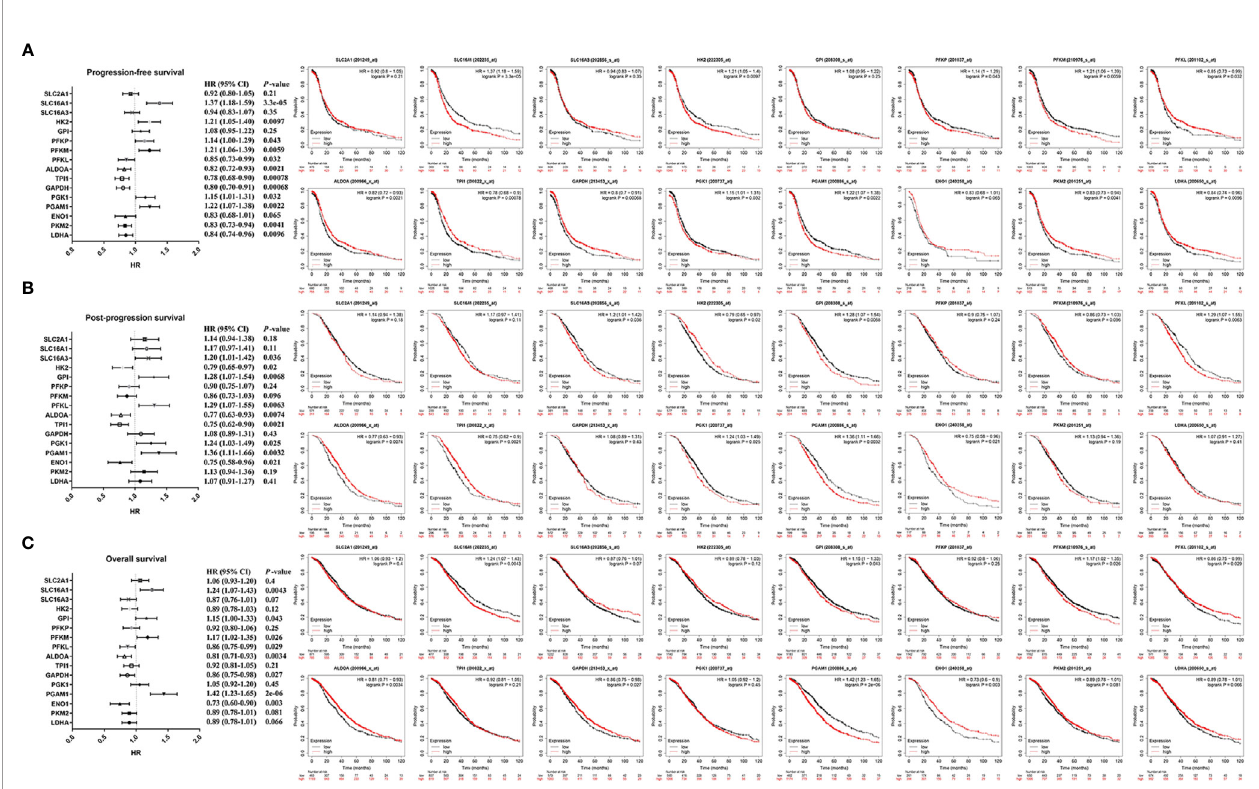
FIGURE 4 | The prognostic value of glycolysis-related genes in ovarian cancer. (A) The prognostic value of glycolysis-related genes in ovarian cancer (PFS in Kaplan-Meier plotter). (B) The prognostic value of glycolysis-related genes in ovarian cancer (PPS in Kaplan-Meier plotter). (C) The prognostic value of glycolysis- related genes in ovarian cancer (OS in Kaplan-Meier